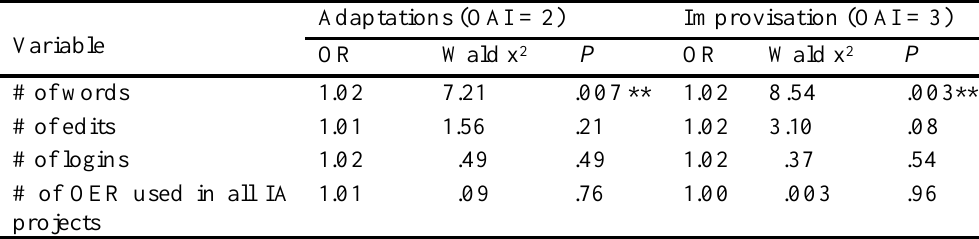
Table 8 Multinomial Logistic Regression on OAI Score for 72 IA Projects